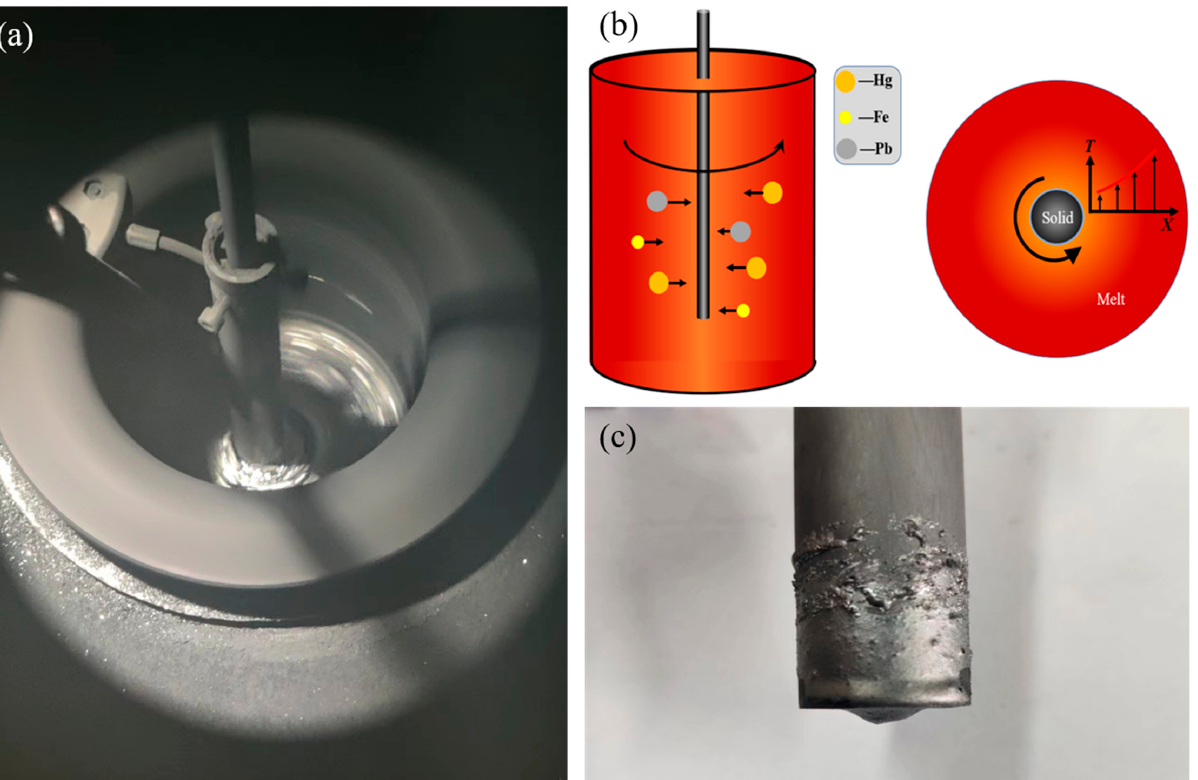
Figure 2. Schematic diagram of the principle of the crystallization process: ( a ) photograph of the crystallization process; ( b ) structural schematic diagram of the crystallization process; ( c ) the cooled finger .